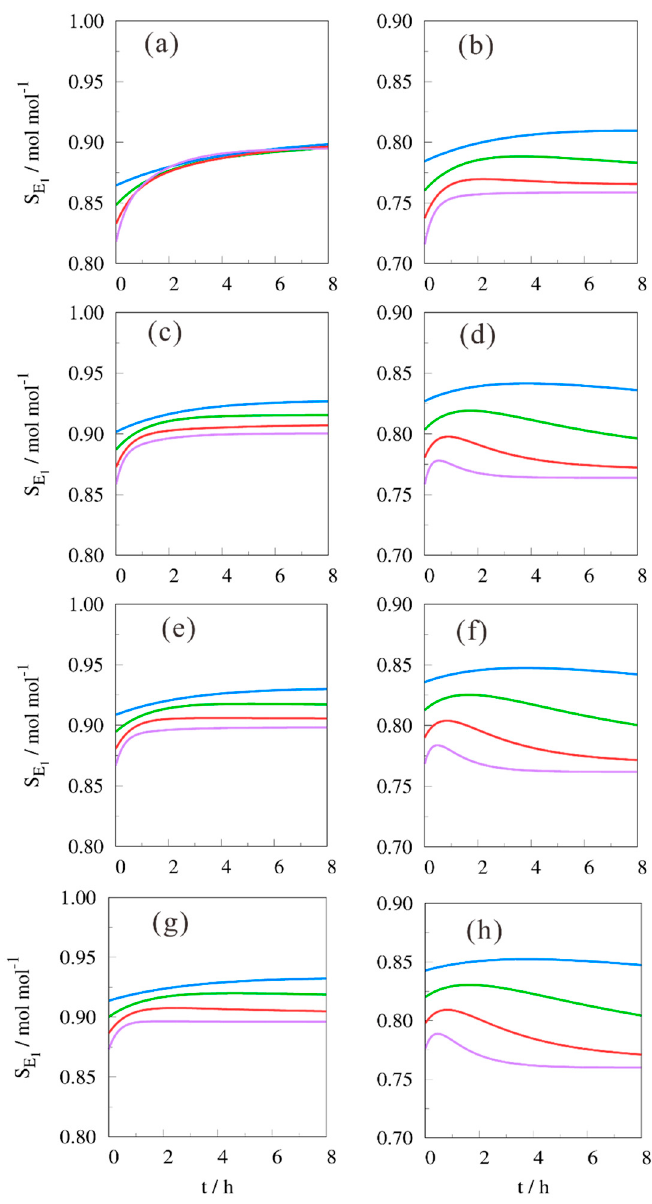
Figure 2. E 1 product distribution versus reaction time. Solvent = ( a , b ) methanol, ( c , d ) ethanol, ( e , f ) n-propanol, ( g , h ) n-butanol; (a,c,e,g) (B / H) 0 = 2 mol · mol − 1 and (b,d,f,h) ( B / H ) 0 = 1 mol · mol − 1 ; T = ( – ) 80 ◦ C, ( – ) 100 ◦ C, ( – ) 120 ◦ C, ( – ) 140 ◦ C.